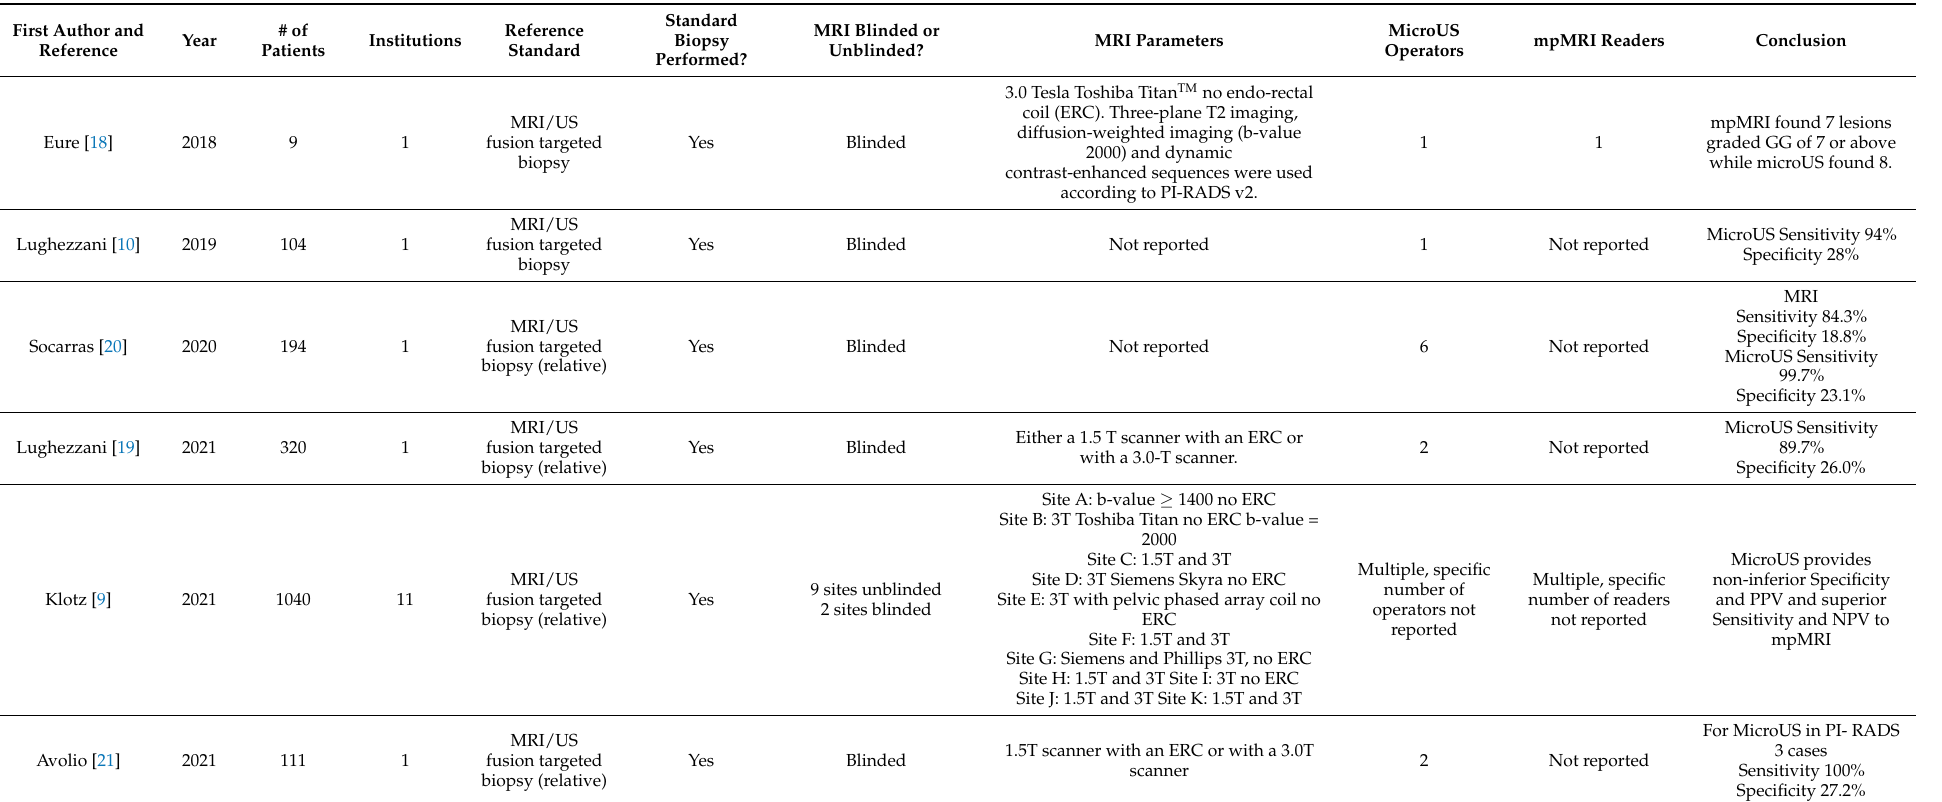
Table 1. Summary of mpMRI and microUS comparison